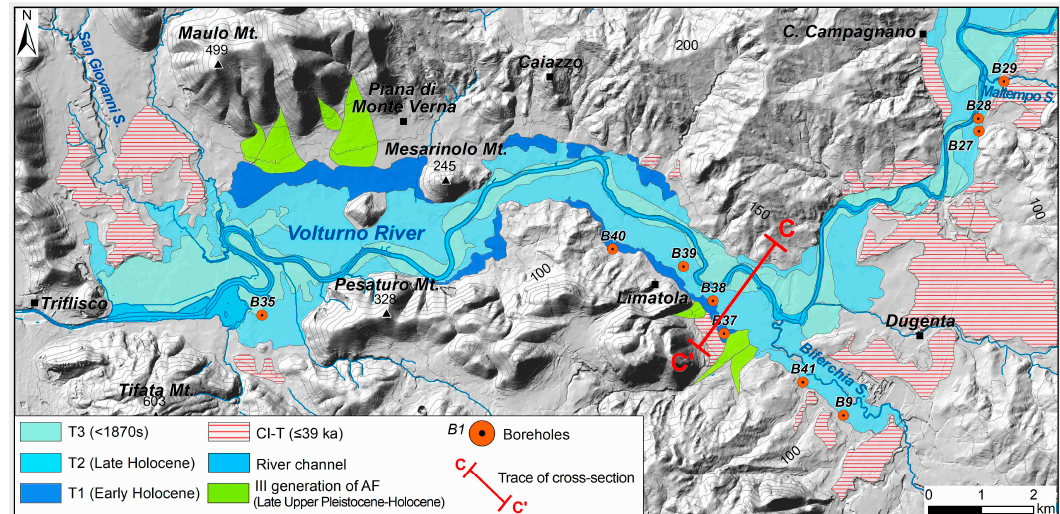
Figure 14. Geomorphological sketch of sector C.